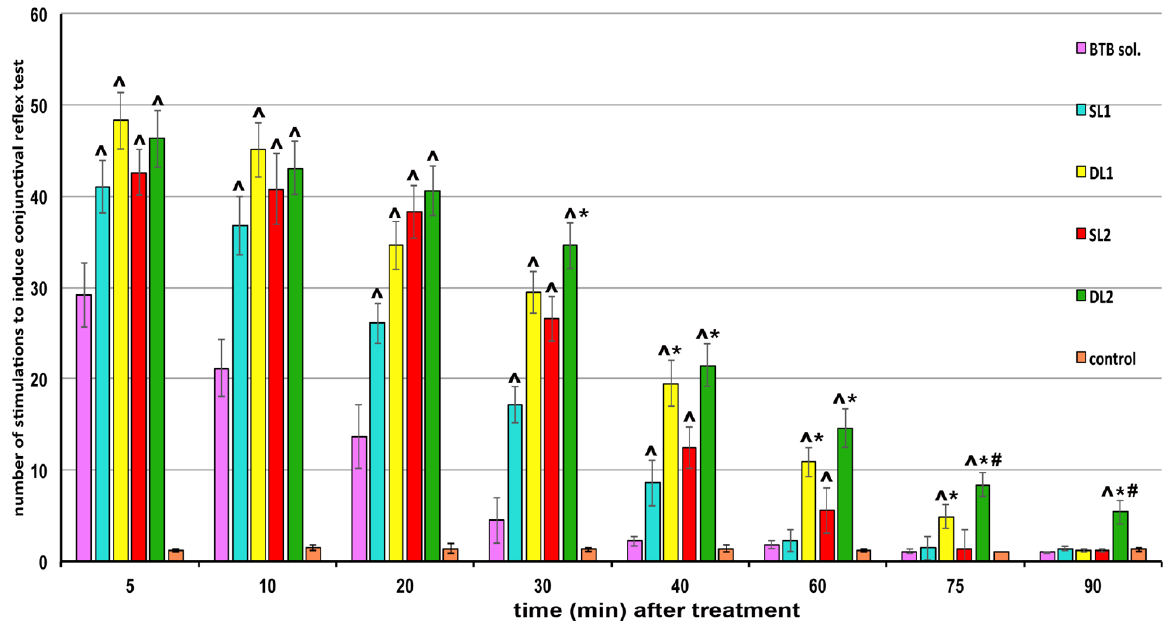
Figure 6. Effect induced on the rabbit conjunctival reflex test by different Carbopol gel formulations containing 0.5% butamben (BTB) as hydroalcoholic solution or single-loaded (SL) or double-loaded (DL) liposomal formulations (see Table 3 for liposomal formulations composition). Six rabbits per group. Mean of six experiments. The control consisted of a Carbopol gel containing the corresponding formulation without drug. Note: ˆ p < 0.05 vs. drug solution; * p < 0.05 vs. SL formulation; # p < 0.05 vs. DL1 formulation.